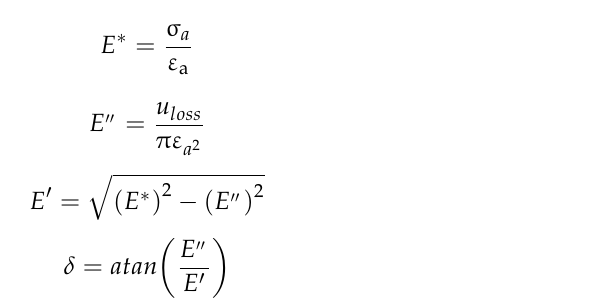
Figure A2. Experimental cyclic stress–strain relationship of the PlatsilGel OO30 material.